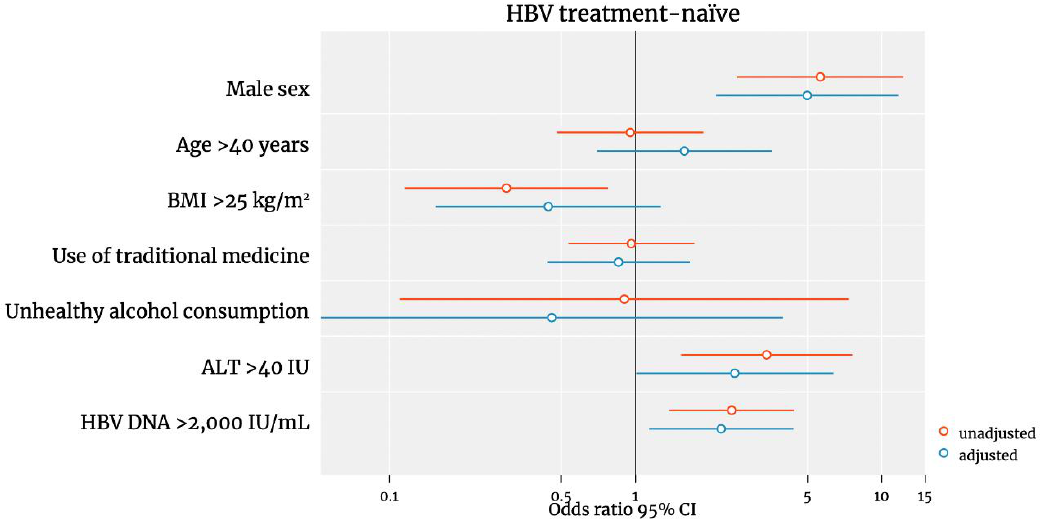
Figure 3. Predictors of significant liver fibrosis among treatment-naïve pwHBV. Odds ratios were plotted on a logscale.